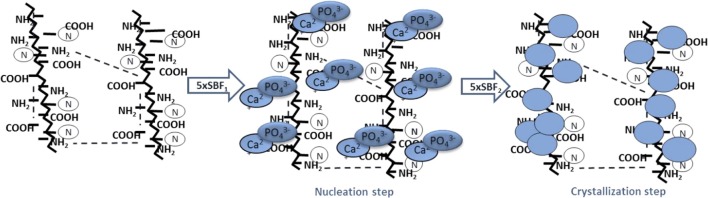
Biomimetic treatment by using supersaturated SBF solutions. Nucleation step obtained by incubation of samples in 5 × SBF1 for 3 days at 37°C pH = 6.5 followed by crystallization step by using a modified 5 × SBF2 for 4 days at 37°C pH = 6.0.